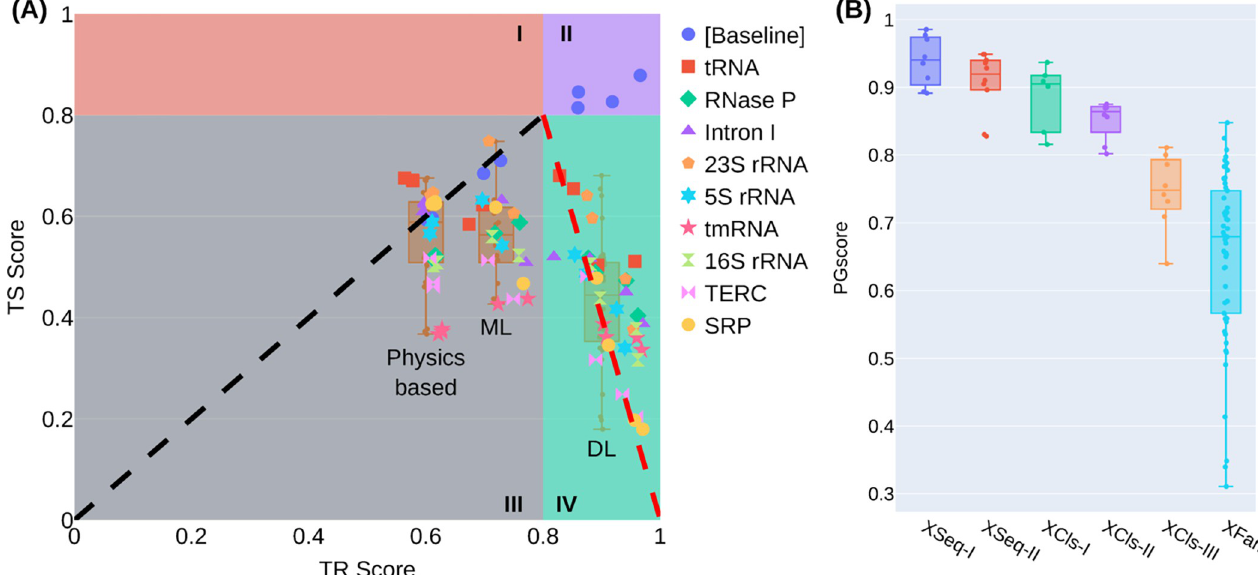
Fig 5. Illustrations of the cross-family F1 scores and the PGscore distributions for all studies. (A) The TS vs. TR F1 scores of the baseline cross-cluster study ([Baseline]) and all nine cross-family studies (labelled by the TS family name) with Strive-NR80. Four zones (I-IV) are delineated for easy reference. The diagonal line in zone III denotes the line of zero TR-TS gap, i.e., TR = TS. The dash line in zone IV is a guide to the eye only. The cross-family TS scores of the three groups of models (physics-based, ML, and DL) are shown in three respective boxplots as annotated. (B) Boxplots of the PGscores from all learning-based models for each study at the specific TR-TS similarity level. The studies are, XSeq-I: the cross-sequence study with Stral-NR100, XSeq-II: cross-sequence with Stral-NR100 and Archi-NR100, XCls-I: cross-cluster with Strive-NR80, XCls-II: cross-cluster with Stral-NR80 and Archi-Stral-NR80, XCls-III: cross-cluster with bpRNA, XFam: all nine cross-family studies with Strive-NR80. The learning-based models included for each study are shown in Figs T-U in S1 Text.